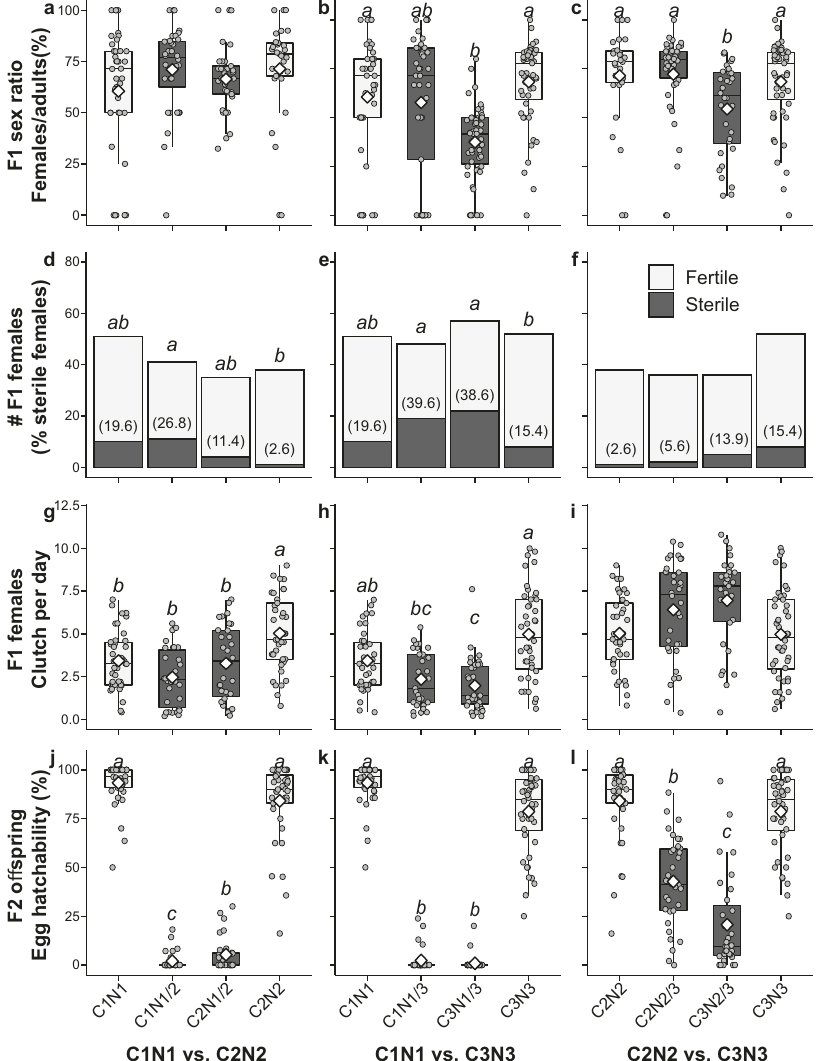
Fig. 4 Reproductive compatibility of fi eld-derived Tetranychus urticae lines. Reciprocal crosses were performed between different iso-female lines belonging to genotype groups C1N1, C2N2 and C3N3. Fitness traits measured in individuals across two fi lial generations are presented on the y -axes of each row. F1 adult sex ratio, F1 female clutch per day, and F2 egg hatchability are presented in boxplots showing each data point (grey dots), the median (black line within the interquartile range box), the mean (white diamond) and the bottom 25% and the top 25% of the data values (whiskers); reciprocal ♀ × ♂ crosses are presented in black boxes and their respective controls in light grey boxes. F1 female sterility is presented as the number of females (fecund females in light grey and sterile females in dark grey) with the percentage of sterile females in parenthesis. Letters above bars and boxes represent signi fi cant differences within each panel. Sample sizes, chi-square and F-statistics, and p -values are speci fi ed in Supplementary Tables 2 and